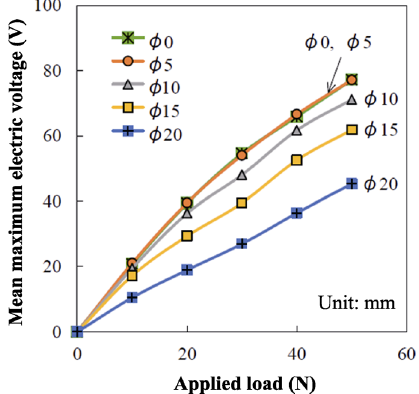
Fig. 4 Mean maximum voltage as a function of load applied by various loading